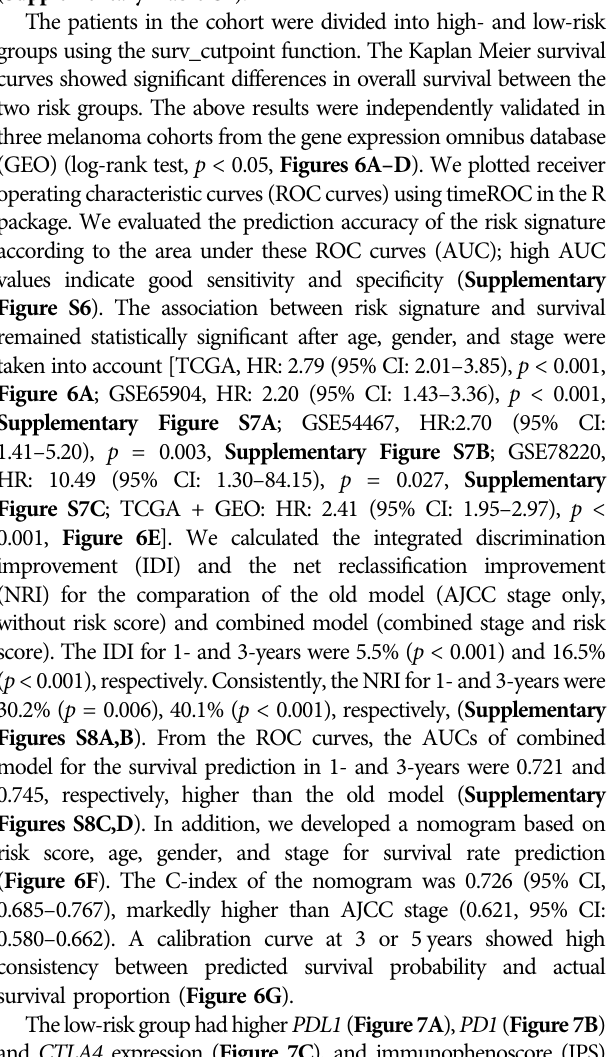
Figure 6A ; GSE65904, HR: 2.20 (95% CI: 1.43 – 3.36), p < 0.001, Supplementary Figure S7A ; GSE54467, HR:2.70 (95% CI: 1.41 – 5.20), p (cid:1) 0.003, Supplementary Figure S7B ; GSE78220, HR: 10.49 (95% CI: 1.30 – 84.15), p (cid:1) 0.027, Supplementary Figure S7C ; TCGA + GEO: HR: 2.41 (95% CI: 1.95 – 2.97), p